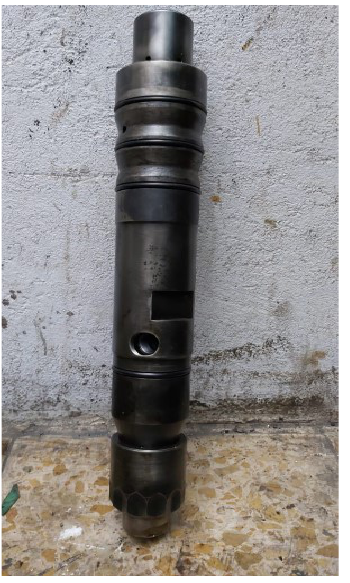
Fig. 3. The Injector.